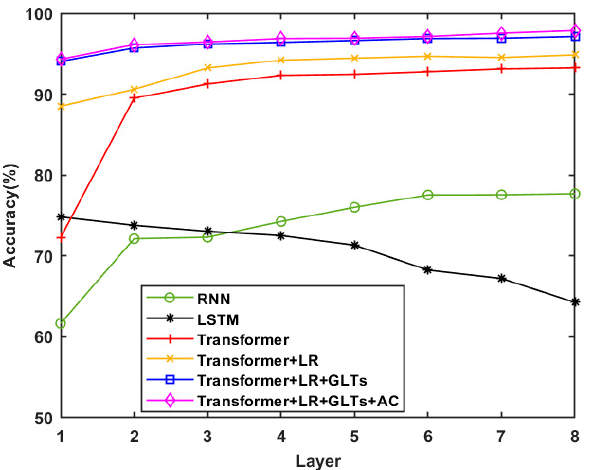
Figure 5. Relationship between the number of layers and the recognition accuracy.